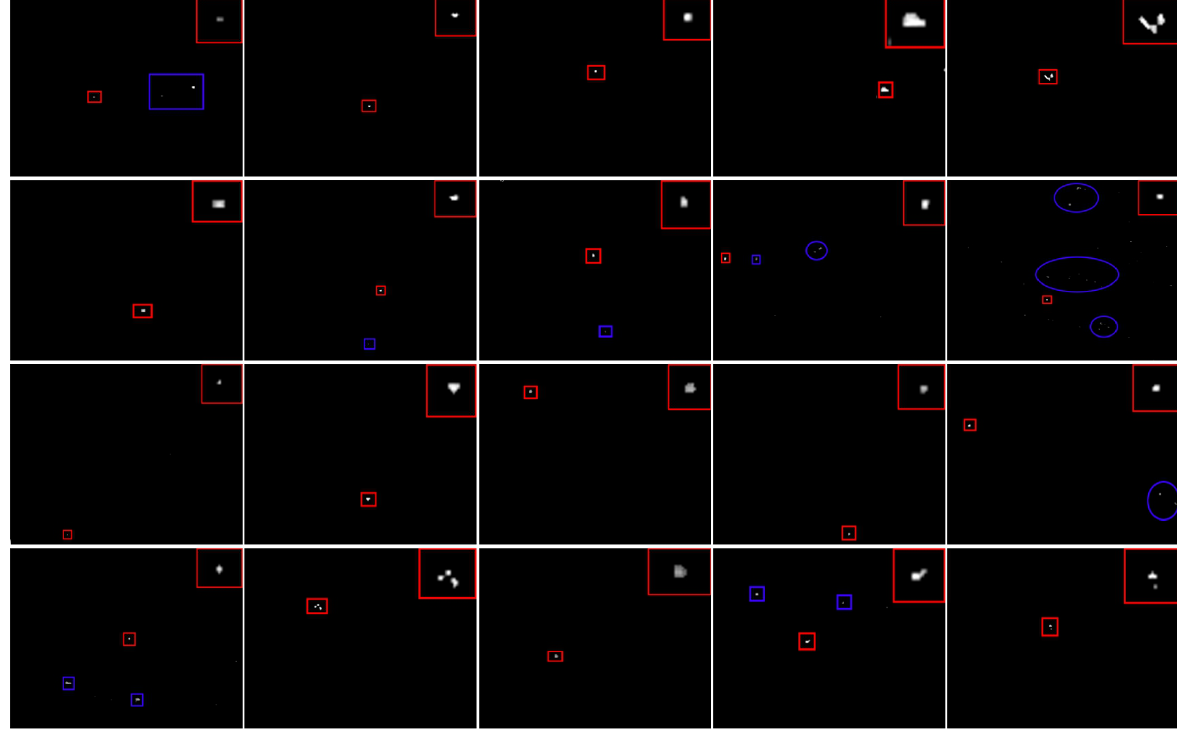
Figure 11. Twenty single-frame image results processed by PSTNN.